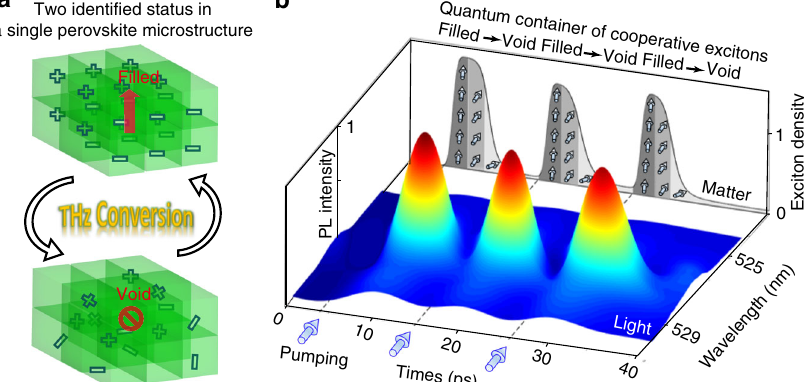
Fig. 5 Terahertz conversion based on a CsPbBr 3 QDSM. a The schematic illustrations of the “ Filled “ and “ Void ” states for the perovskite quantum container. b Experimental demonstration of a quantum container with an ultrafast conversion of excitonic quantum ensemble, accompanying with the optical response of the CESF signals. The blue arrows along the x -axis indicate the excitation times. The arrows along the side plane represent the population status of the many-body quantum